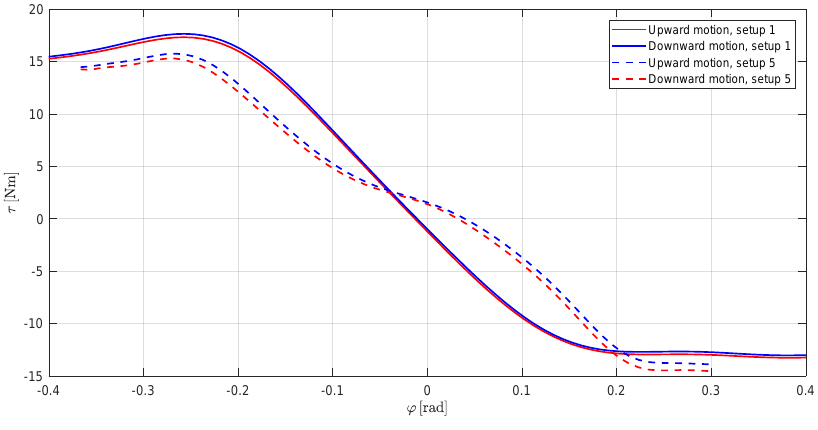
Figure 7. Measured reaction torque about rotation axis for slow forced oscillation in calm water with Setups 1 and 5.